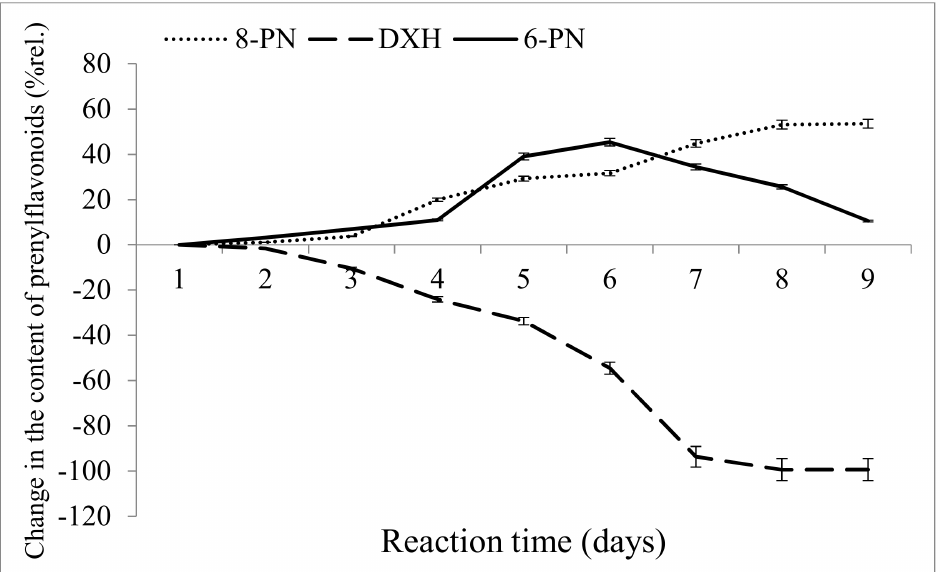
Figure 3. Isomerization of desmethylxanthohumol to 6-prenylnaringenin and 8-prenylnaringenin in the spent hops after CO 2